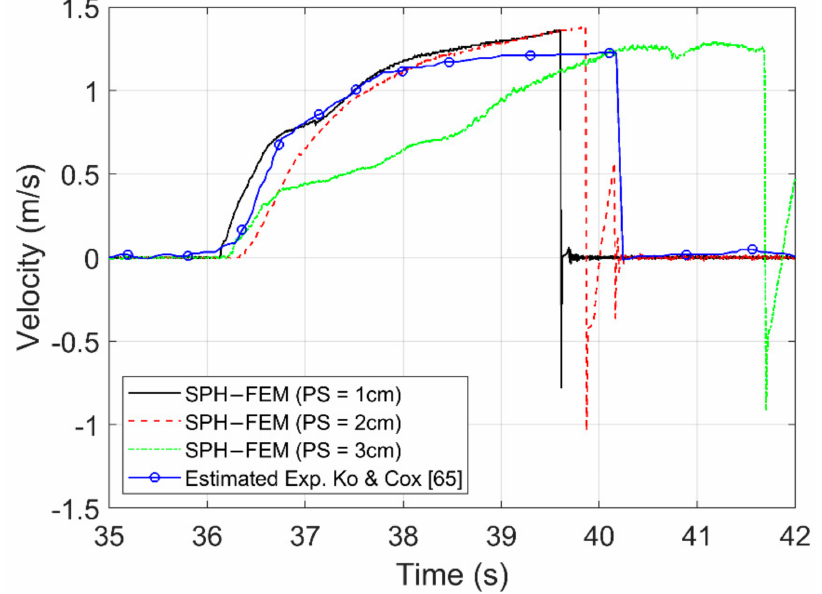
Figure A2. Debris velocity histories. Estimated based on the experimental tests of [65] and numerical results for three particle sizes, for h 1 = 2.496 m and T erf = 30